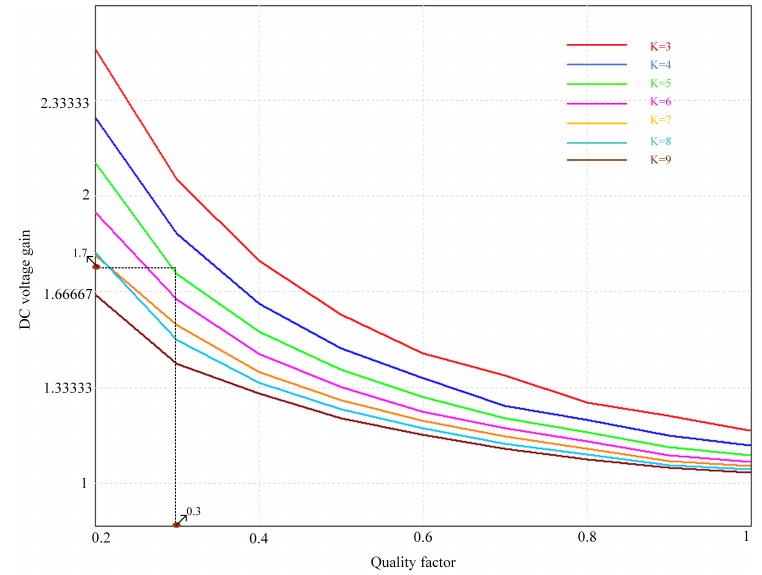
Figure 4. Plots of quality factor and DC voltage gain with different values of K.